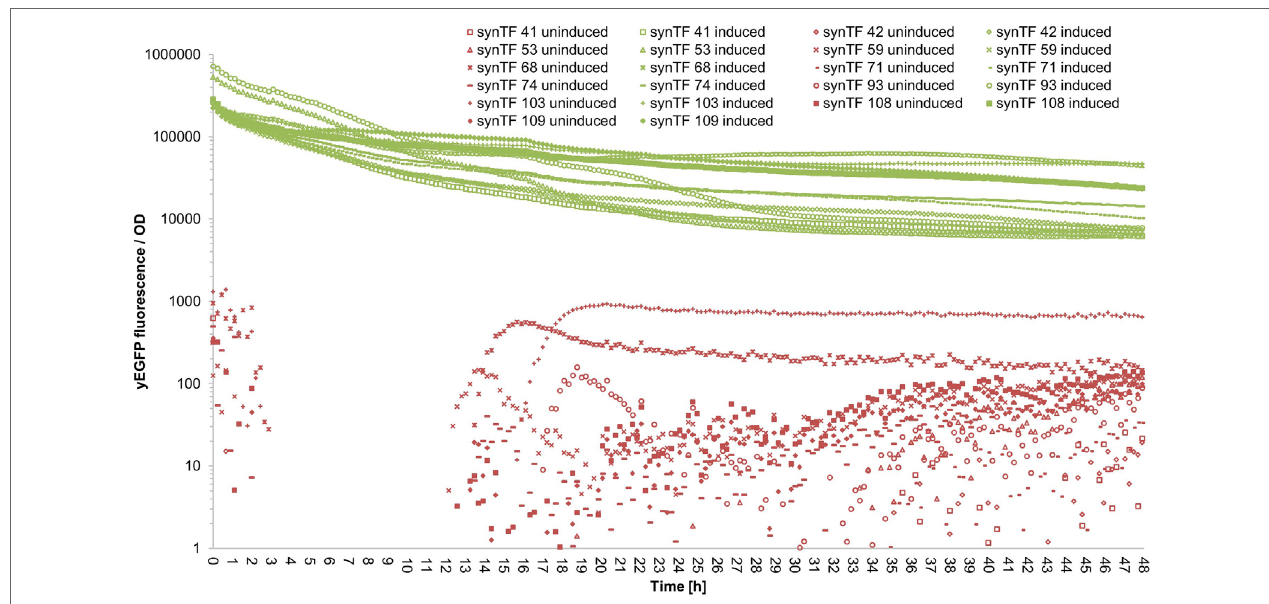
FigUre 5 | Fluorescence/OD values of selected synthetic transcription factors (synTFs) over a 48-h cultivation period. Cells expressing synTFs were grown in inducing and non-inducing medium in a 96-well plate. Fluorescence and OD 600 nm readings were taken approximately every 12 min. Fluorescence values were divided by the corresponding OD to account for differences in cell density. synTF numbering refers to Table S3 in Supplementary Material. Values are mean values from two biologically independent replicates, each with two technical replicates. For better readability, standard deviations are not indicated here, but given in Table S5 in Supplementary